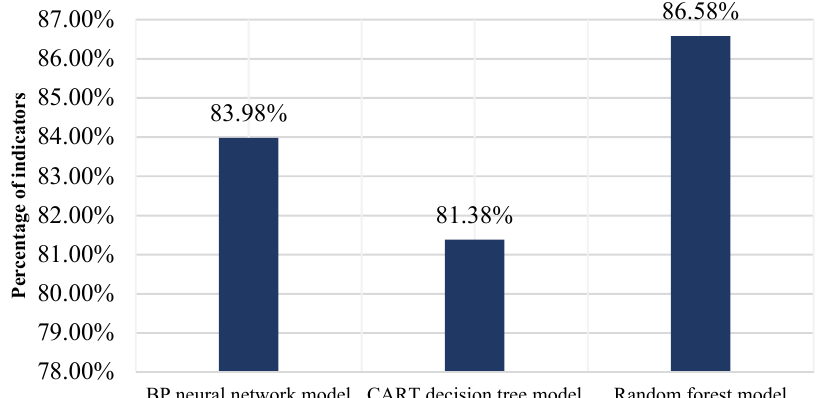
Figure 7. Comparison of model prediction accuracy.